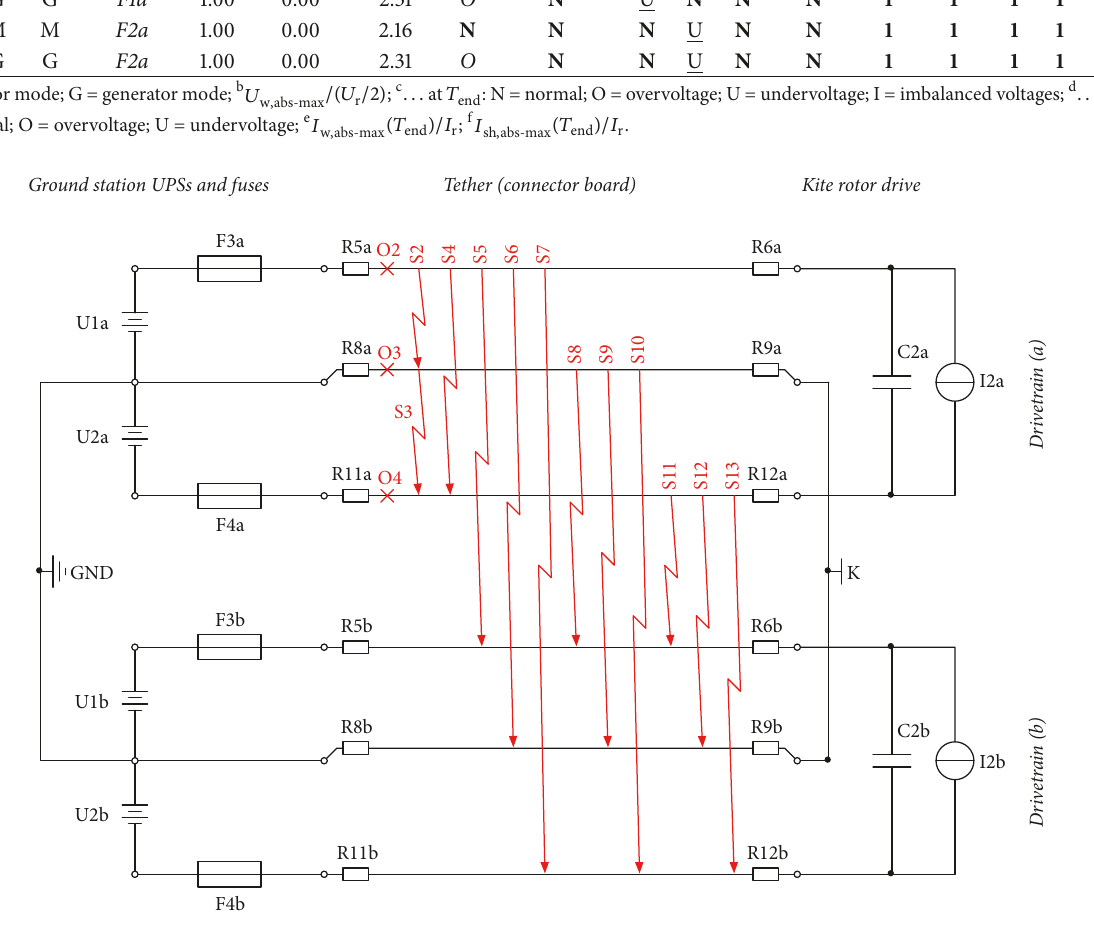
Figure 15: Equivalent circuit diagram of demonstrator with symbols as in Figure